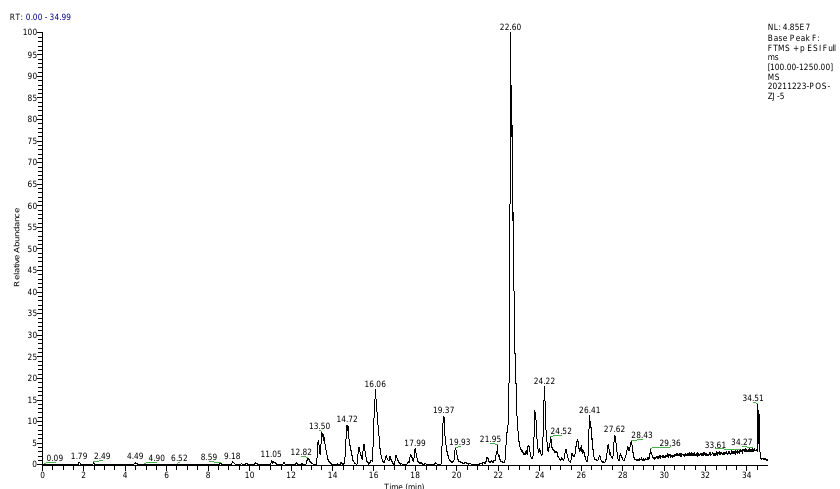
Figure 8. Total ion current chromatogram of IPBC degradation by UPLC − MS/MS.